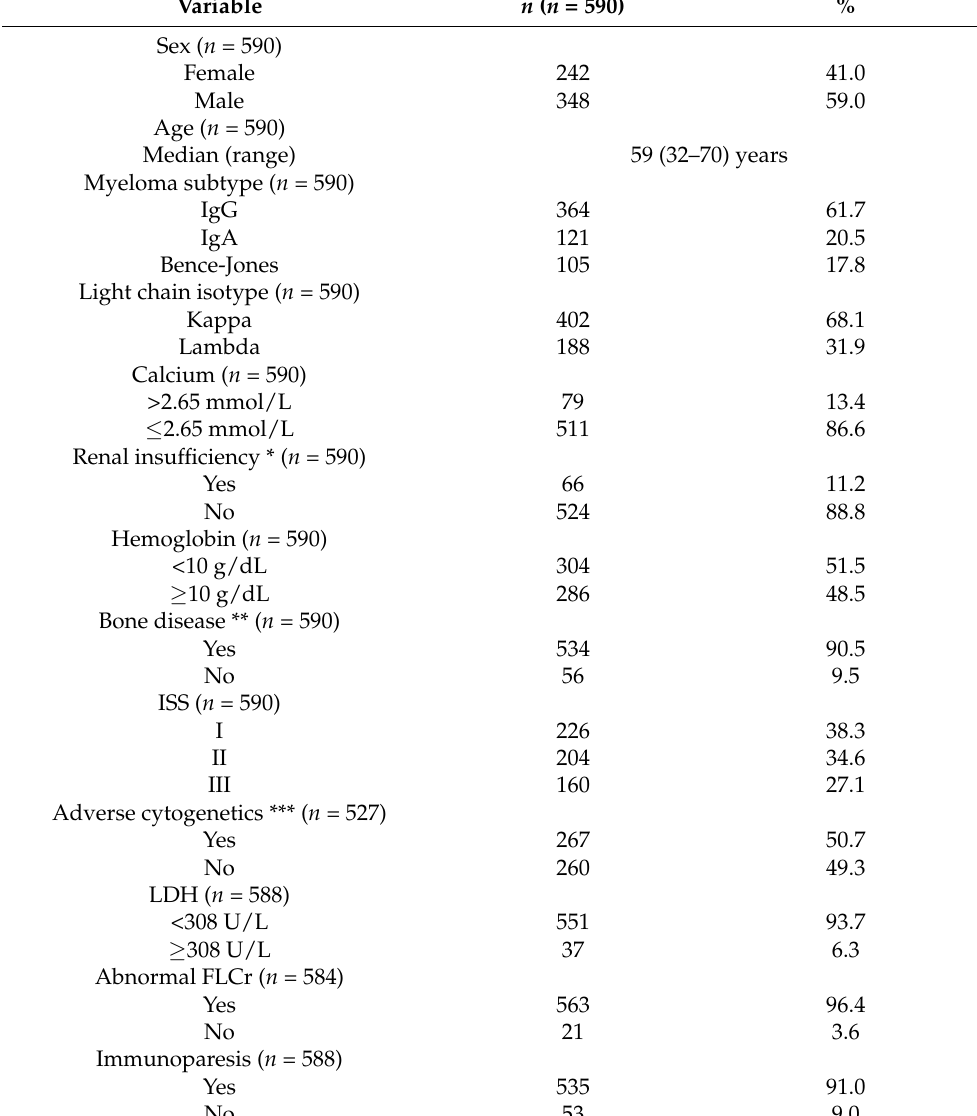
Table 1. Baseline characteristics of the analysis